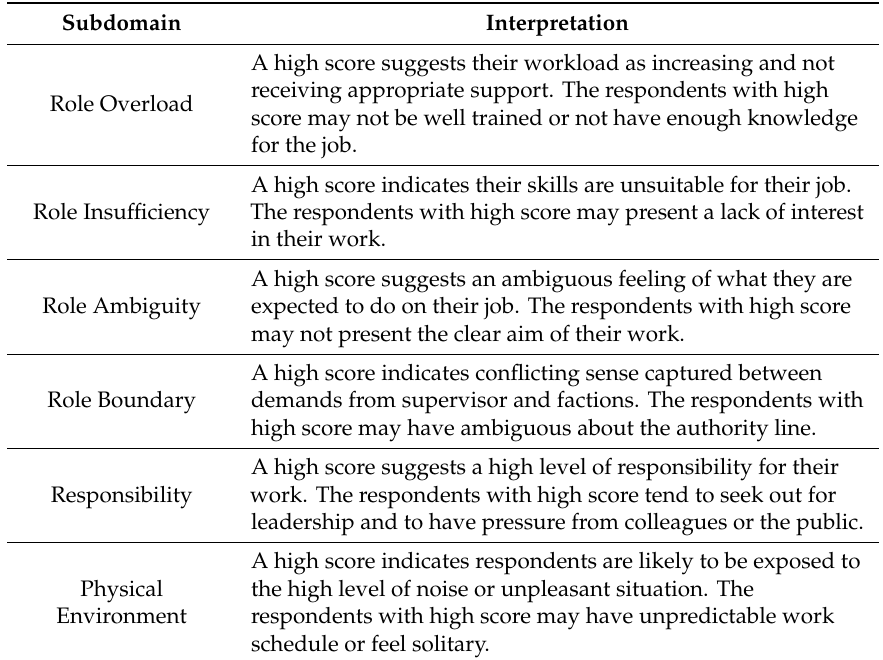
Table 1. High score interpretation of the Occupational Role Questionnaire